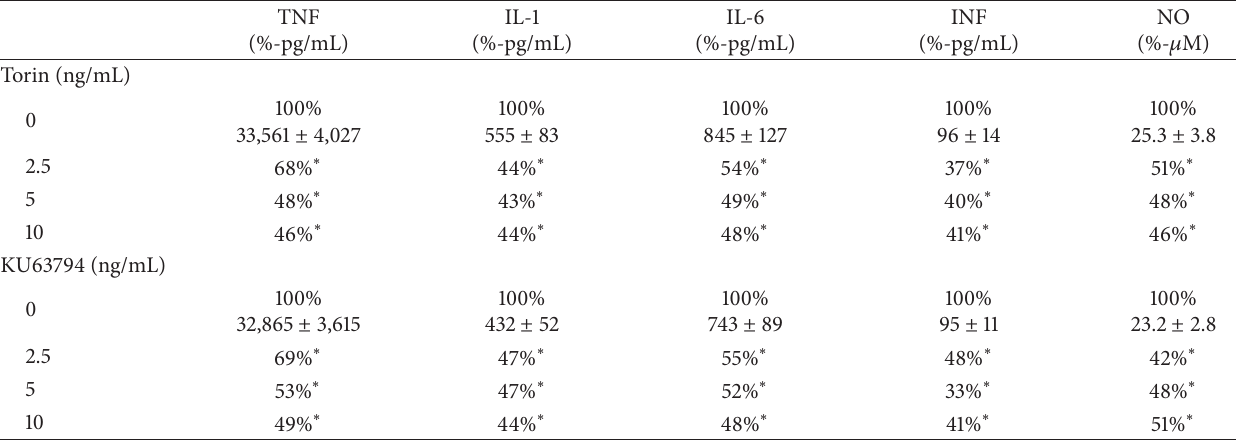
Table 1: The table indicates the reduction from the control of RAW264.7 macrophages inflammatory response in the presence of 0, 2.5, 5, and 10ng/mL Torin (up) and KU63794